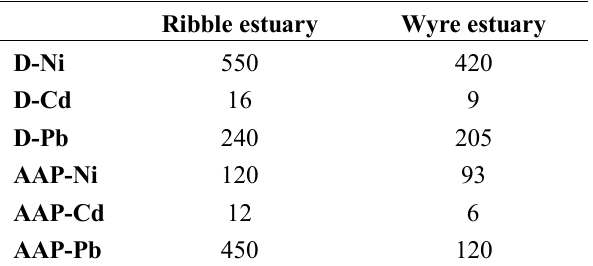
Table 4. Load estimates of dissolved metals discharged into the Ribble and Wyre estuaries (t y −1